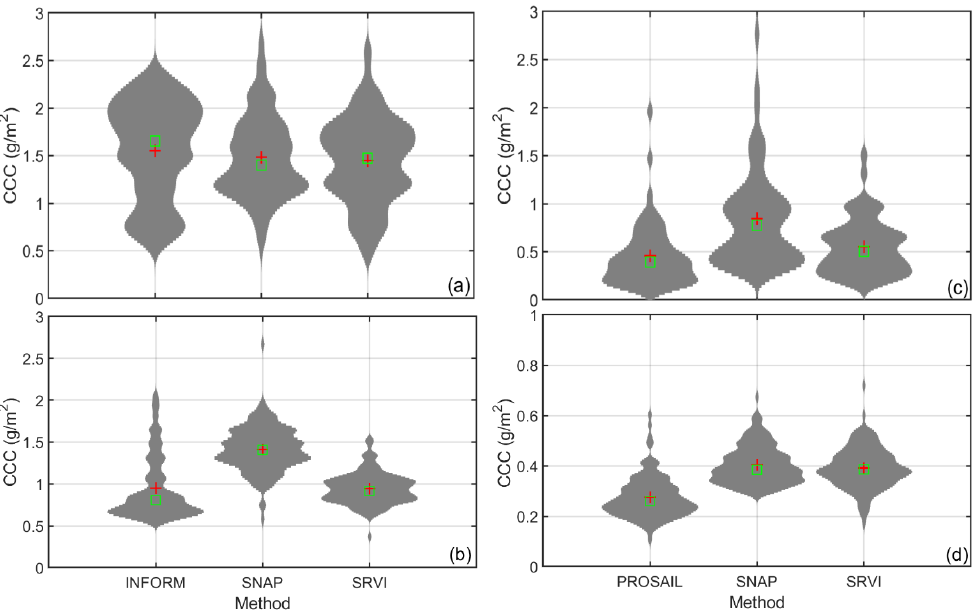
Figure 6. Violin plots of predicted CCC (g / m2), showing the di ff erences in frequency distribution among four biomes; ( a ) temperate forest, ( b ) wetland, ( c ) tropical forest, and ( d ) arctic tundra. The square and the plus sign indicate the median and mean of the predicted CCC by each method. Table 6. Results of paired t-test and Kolmogorov-Smirnov test (p = 0.01) to measure the mean di ff erence in CCC and spatial distribution disparities among pairs of CCC products,